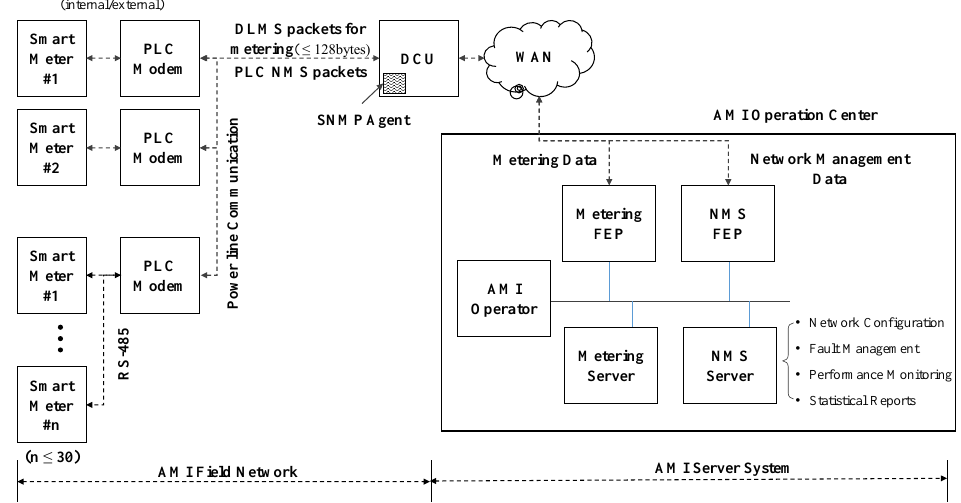
Figure 1. KEPCO AMI system based on PLC. DCU collects metering and NMS information data.